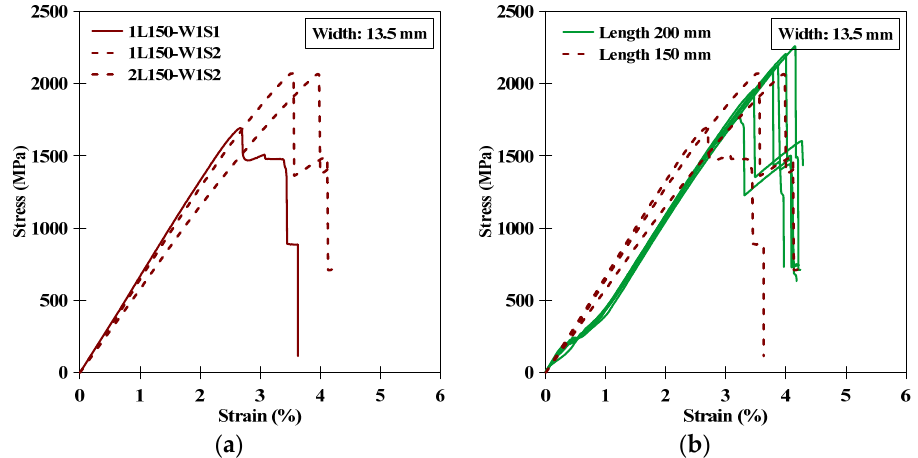
Figure 12. ( a ) Stress–strain curves of the 150 mm long specimens that were clamped using leather for different displacement rates and ( b ) comparison between the 200 and 150 mm long specimens and different displacement rates.